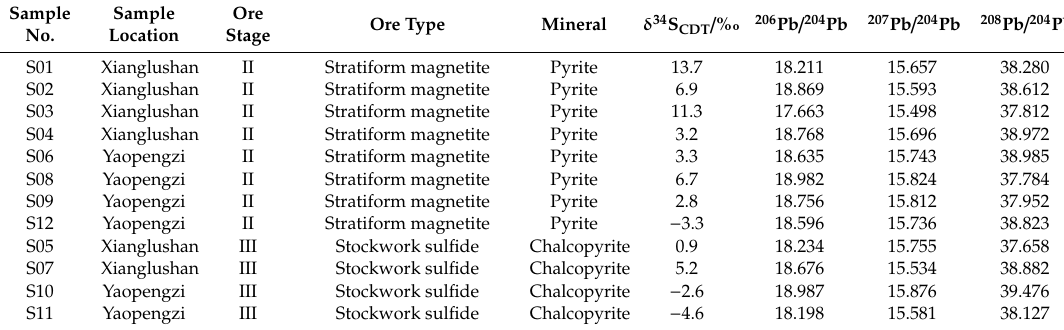
Table 4. Sulfide S-Pb isotope compositions of the Xianglushan Fe-Cu deposit.